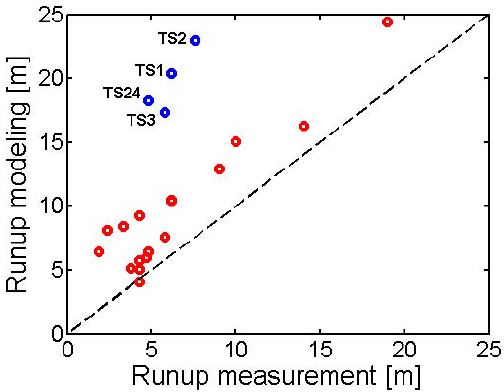
Fig. 8. Scatter diagram for measured and modeled wave